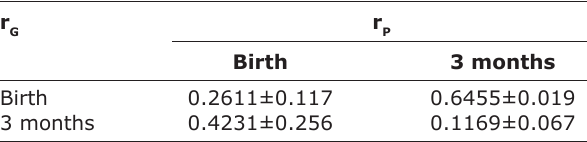
) correlation between birth and weaning G